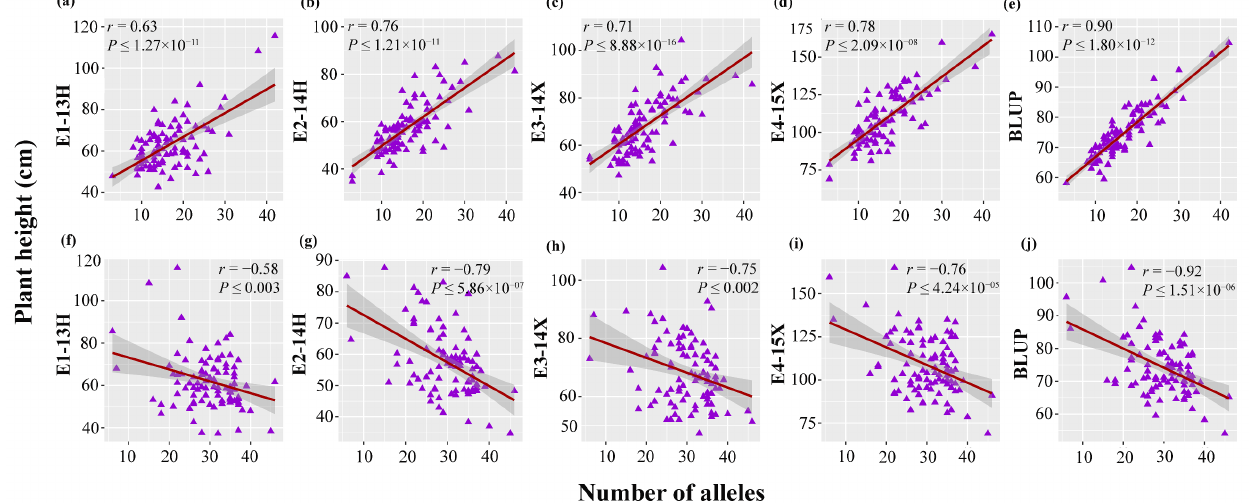
Figure 6. Scatter plot with fitted regression lines representing the correlation between elite/alternative alleles and plant height in tobacco. A positive correlation was calculated between the number of elite alleles and plant height in ( a ) E1-13H, ( b ) E2-14H, ( c ) E3-14X, ( d ) E4-15X, and ( e ) BLUP values. A negative correlation was calculated between the number of alternative alleles and plant height in ( f ) E1-13H, ( g ) E2-14H, ( h ) E3-14X, ( i ) E4-15X, and ( j ) BLUP values. E1-13H: Hukou